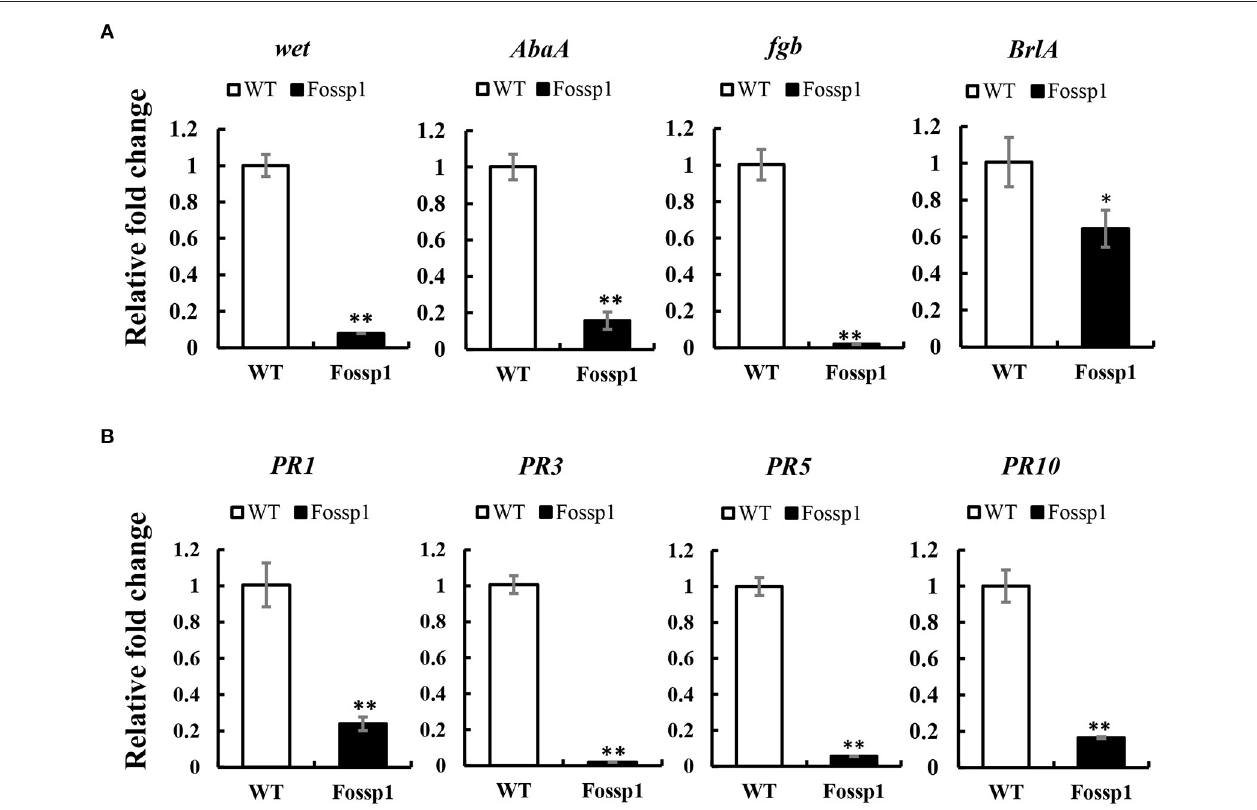
FIGURE 6 | FoSSP1 participates in the sporulation process and plant defense process. (A) The total RNAs were extracted from the spore suspension of WT and Fossp1 cultured for 2 days, and the relative expression of four sporulation related genes was analyzed by quantitative reverse transcriptase-polymerase chain reaction (qRT-PCR), actin gene in Foc4 was used as reference gene. (B) The total RNAs were extracted from banana roots inoculated with WT and Fossp1 spore suspension for 3 days, and the expression of 4 defense-related genes in banana was analyzed by qRT-PCR. Actin gene in banana was used as an internal reference gene in qRT-PCR. The experiment was repeated at least three times. The error bars represent the standard error. Identical and conserved catalytic residues are marked with asterisks (**).